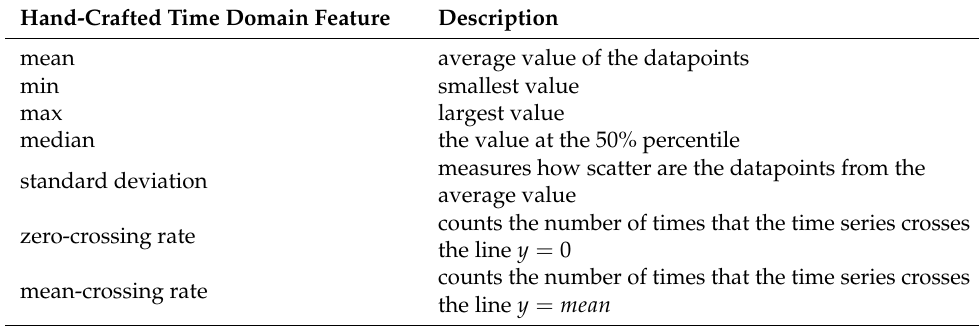
Table 2. Hand-crafted time-domain features and descriptions. Each of these features is calculated over datapoints within each